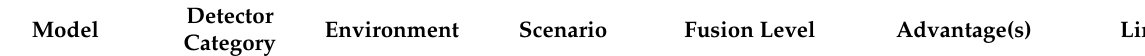
Table 18. Literature Analysis: Camera-LiDAR Fusion-based 3D Object Recognition Methods.